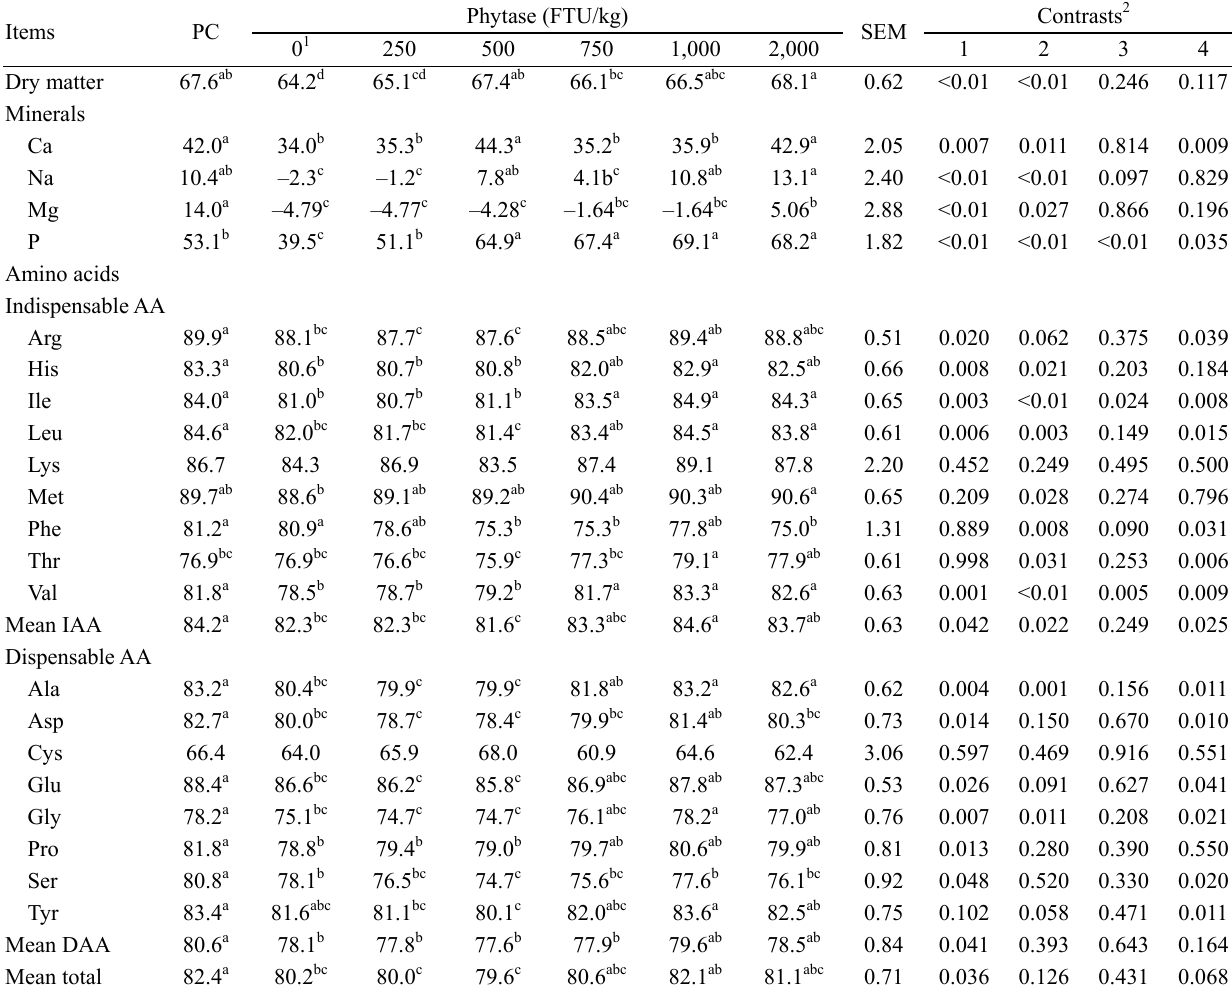
Table 4. Influence of phytase dose on ileal apparent digestibility of minerals and amino acids in 21-d old broilers fed corn/soybean meal